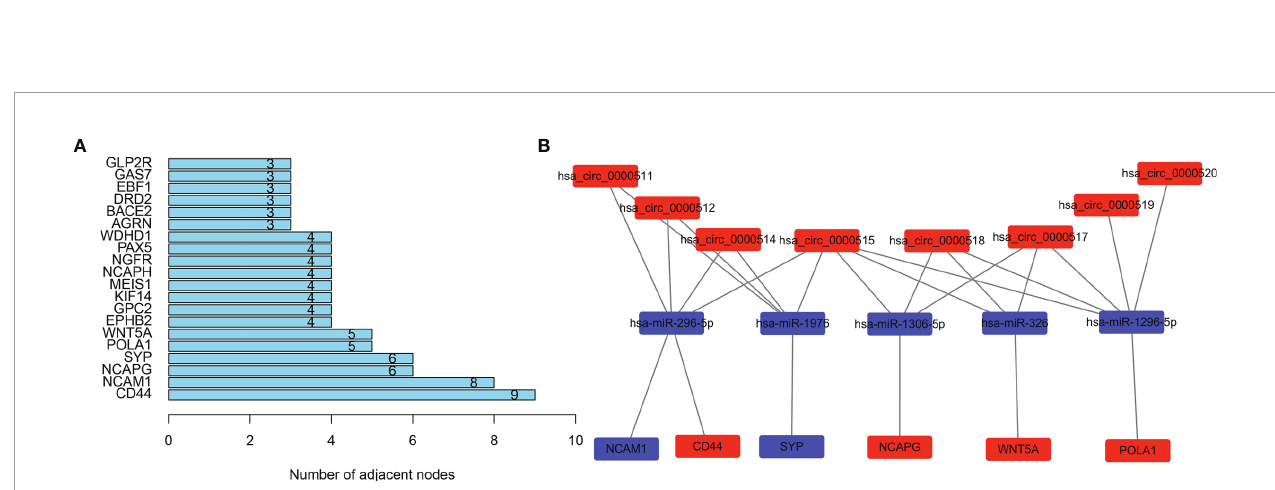
FIGURE 4 | Protein – protein intersection (PPI) network analysis of differentially expressed mRNA (DEmRNA) involved in the competing endogenous RNA (ceRNA)